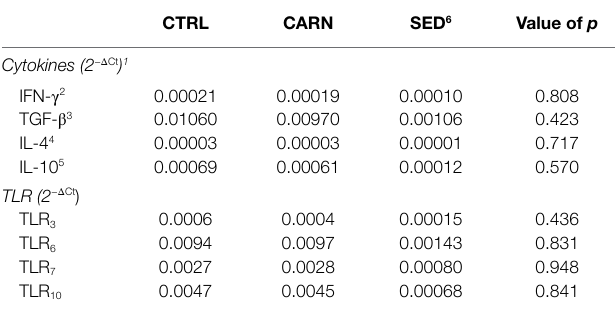
TABLE 8 | Thickness of ileal layers, villus length, crypt depth, infiltrating lymphocyte counts in ileal lamina propria, intensity of staining of M cells in ileal mucosa and ileal IgA concentration of early feed restricted lambs being fed the control (CTRL) or the L-Carnitine diet (CARN) during the fattening period.